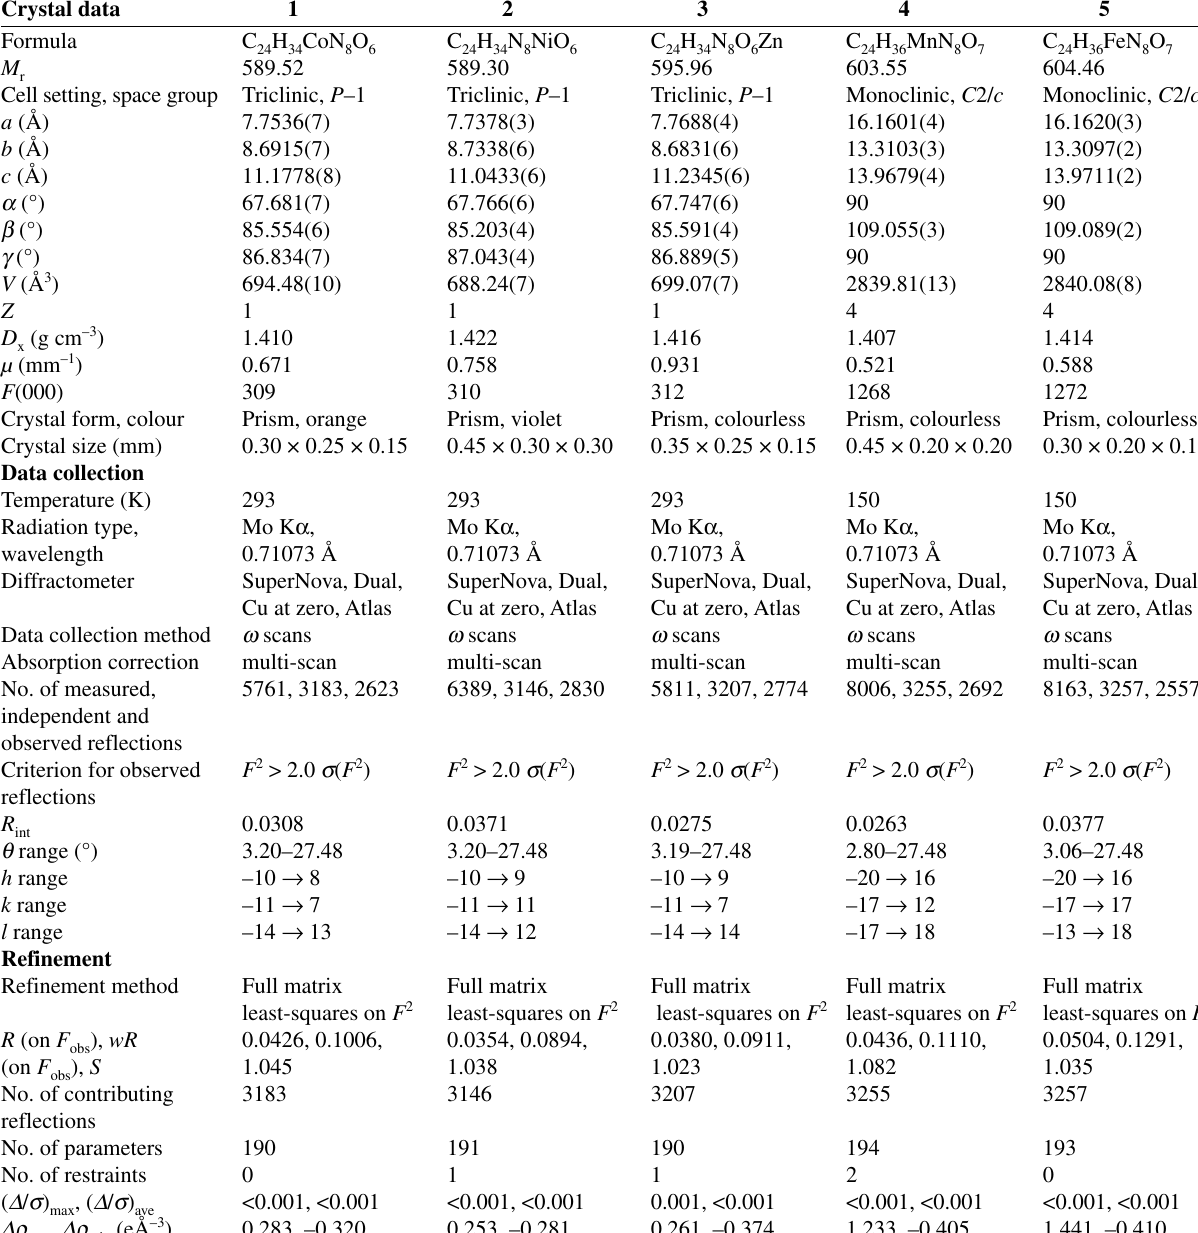
Table 1. Crystal data, data collection and refinement for 1 – 5